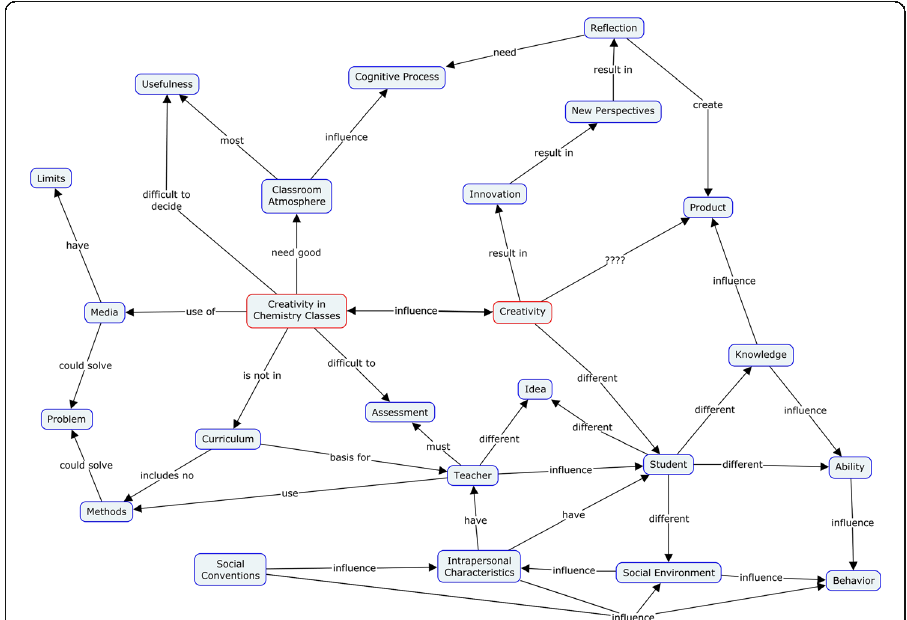
Fig. 2 Example of a concept map with prescribed terms created by a German student teacher. The centres in this map are “ Teacher ” and “ Student ” . There is also a network structure created around those two